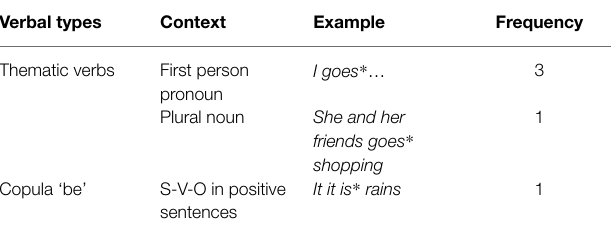
TABLE 5 | Incorrect uses of 3SG verbal inflections in the written task. TABLE 6 | Overgeneralization of plural nominal inflections in the written